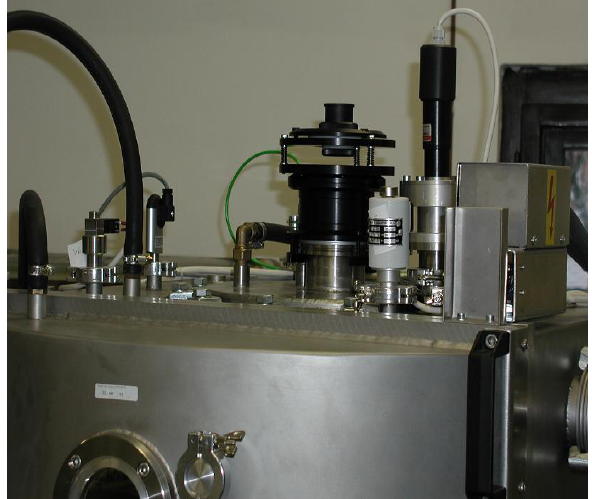
Fig. 6. Vacuum port on the top side of vacuum chamber of coating machine VNA 600 with the holder for photosensor